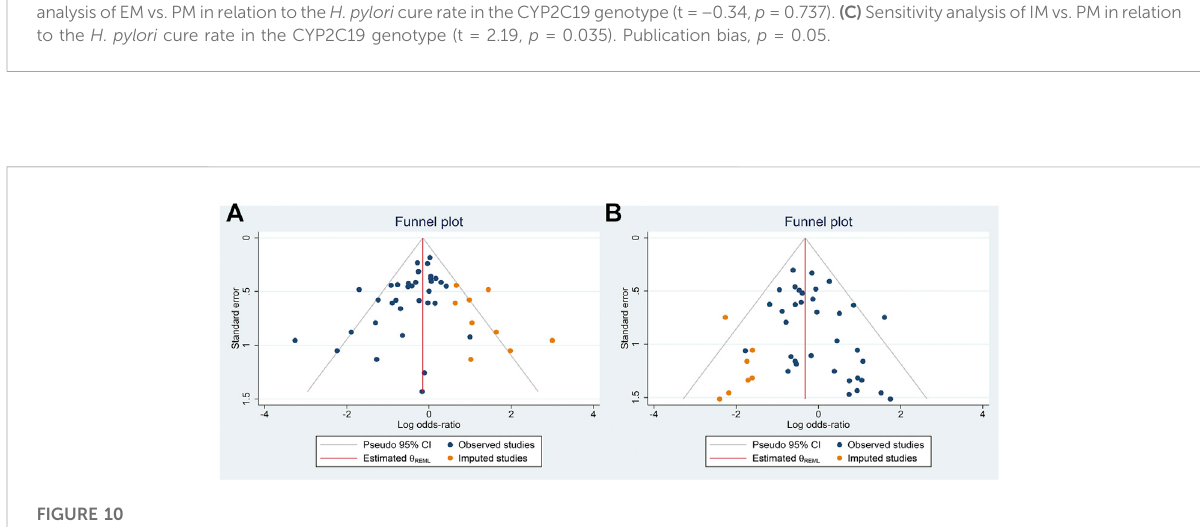
(EM and IM: 80.6% vs. 84.1%, OR = 0.75, 95% CI: 0.61 – 0.91, p = 0.003, P Heterogeneity = 0.043; EM and PM: 80.6% vs. 87.2%, OR = 0.63, 95% CI: 0.49 – 0.79, p = 0.000, p Heterogeneity = 0.388; IM and PM: 84.1% vs. 87.2%, OR = 0.79, 95% CI: 0.63 – 0.99, p =